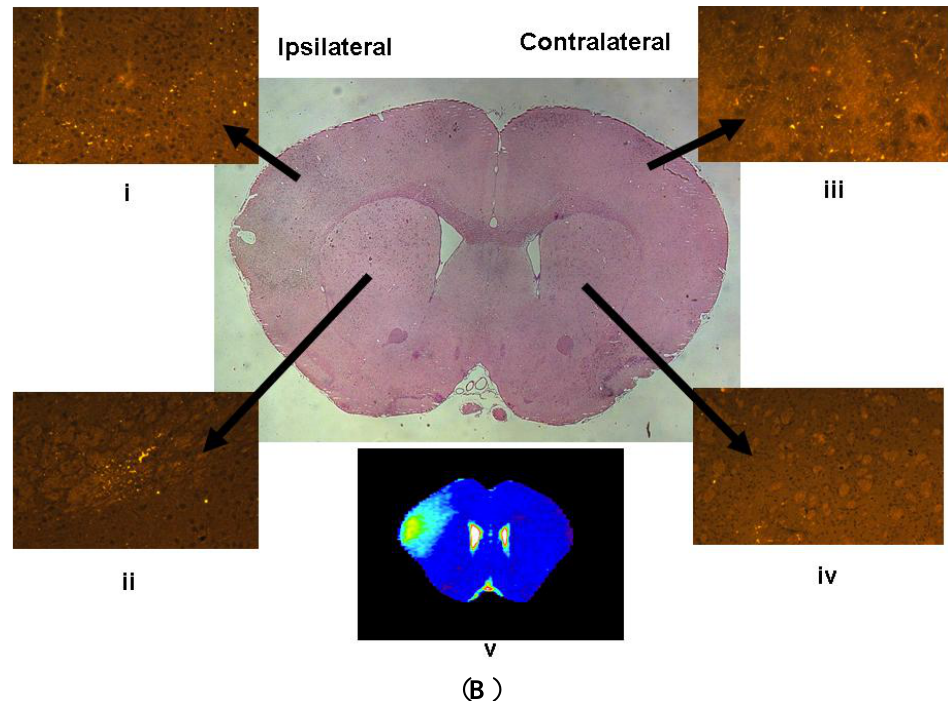
Figure(cid:9)5(cid:9)(B)(cid:9)Figure(cid:9)5(cid:9)(A)(cid:9)